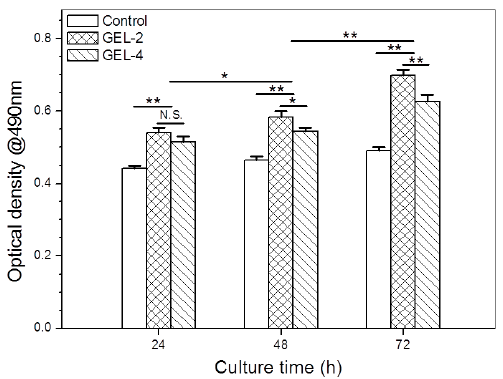
Figure 9. Optical density (OD) values of MC3T3-E1 cells cultured on the surface of gels during various periods ( ∗ , p < 0.05; ∗∗ , p < 0.001; N.S., no significance).